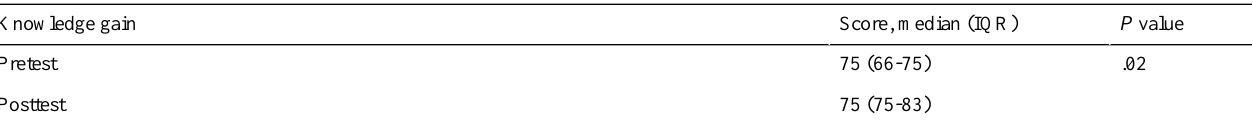
Table 4. Comparison of knowledge gain before and after use of the virtual